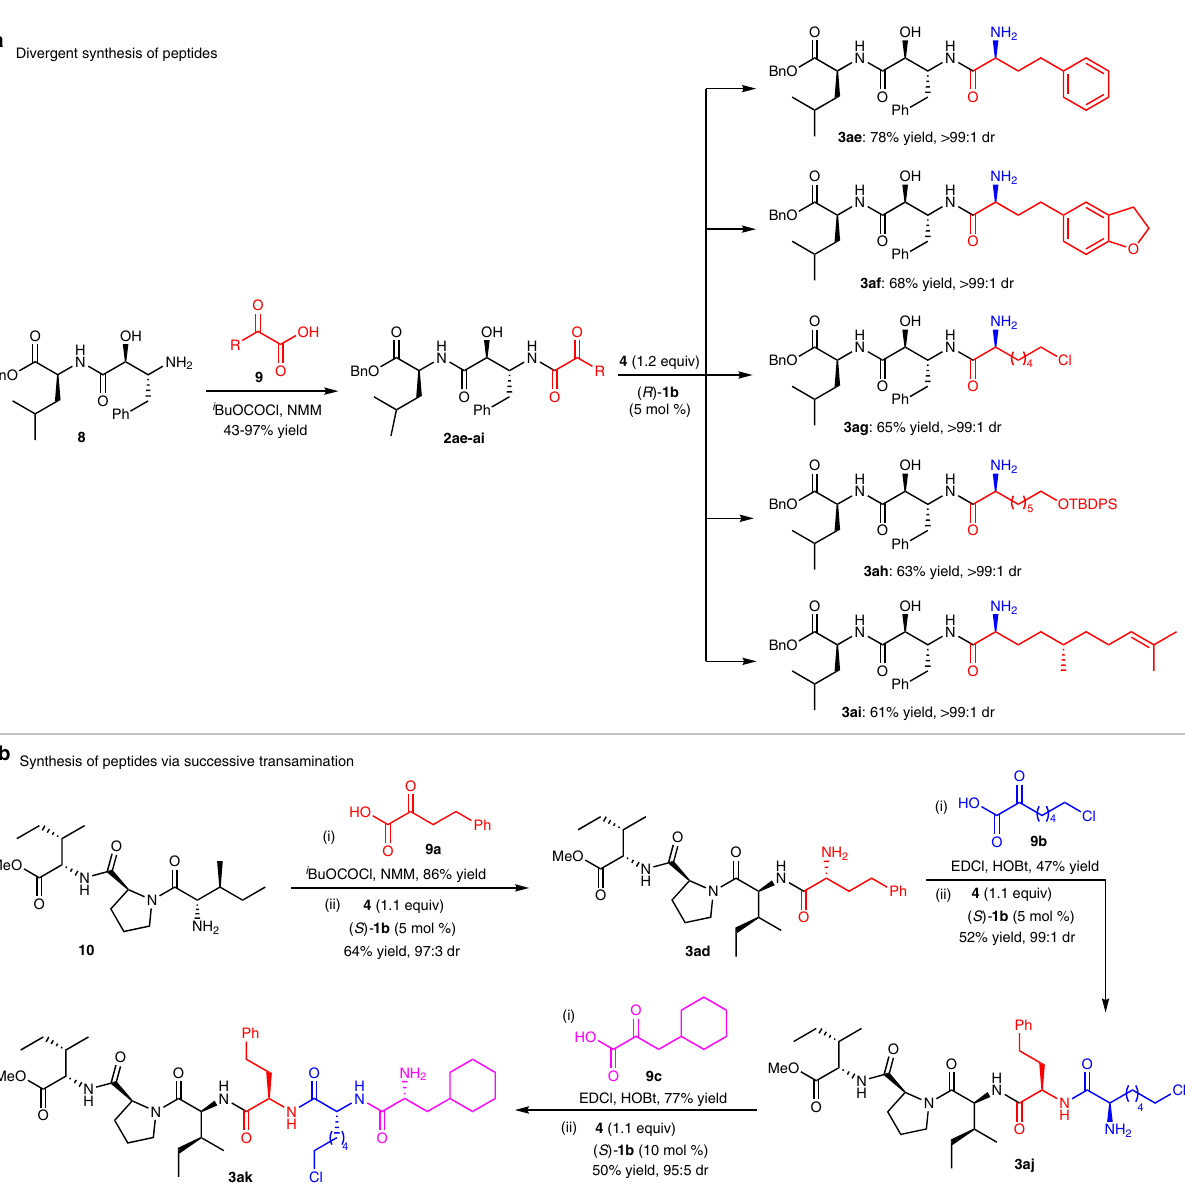
Fig. 5 Synthetic applications. a Divergent synthesis of peptides. NMM = N -methylmorpholine. b Synthesis of peptides via successive